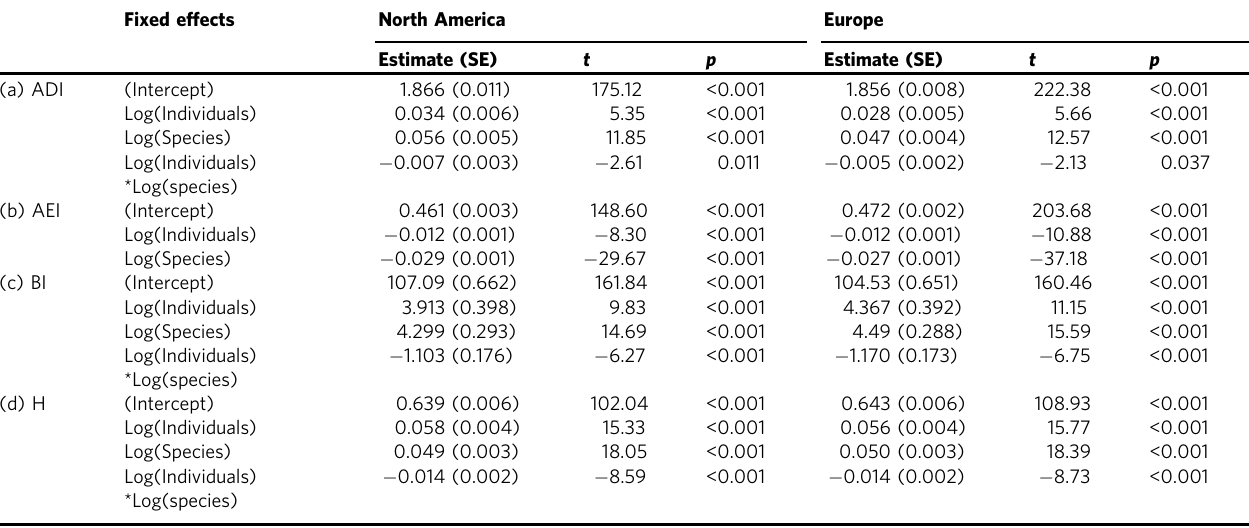
Table 2 Results of GLMs of the association between the acoustic properties of reconstructed soundscapes and the number of individuals (1 – 10) and species (2,3,4,5,10,20,50) present in a simulated community and contributing to that